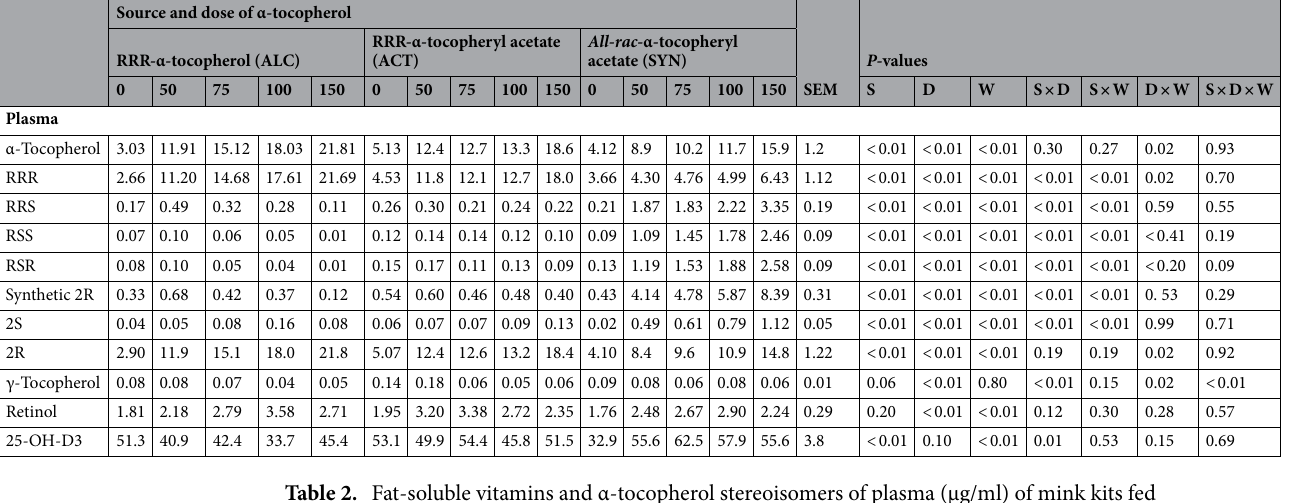
Table 2. Fat-soluble vitamins and α-tocopherol stereoisomers of plasma (µg/ml) of mink kits fed different sources (ALC, ACT and SYN) and doses of α-tocopherol (0, 50, 75, 100 and 150 mg/kg of diet). Synthetic 2R = Summation of synthetic 2R configuration of α-tocopherol stereoisomers ( Ʃ RRS, RSS, RSR), 2S = Summation of S configuration of α-tocopherol stereoisomers, 2R = Summation of R configuration of α-tocopherol stereoisomers, S = Effect of source, D = Effect of dose, W = Effect of weeks, S × D = Interaction between source and dose, S × W = Interaction between source and weeks, D × W = Interaction between dose and weeks, S × D × W = Interaction between source, dose and weeks. Presented values in Table are LS-means